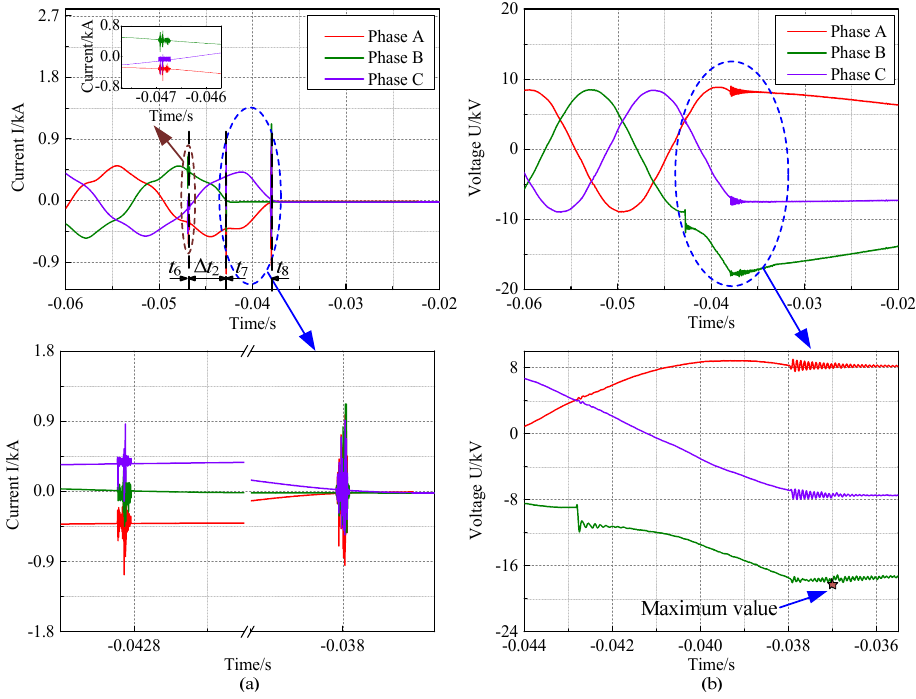
Figure 12. Waveforms of the opening current and capacitor voltage in Case 5. ( a ) Current waveform; and ( b ) voltage waveform.